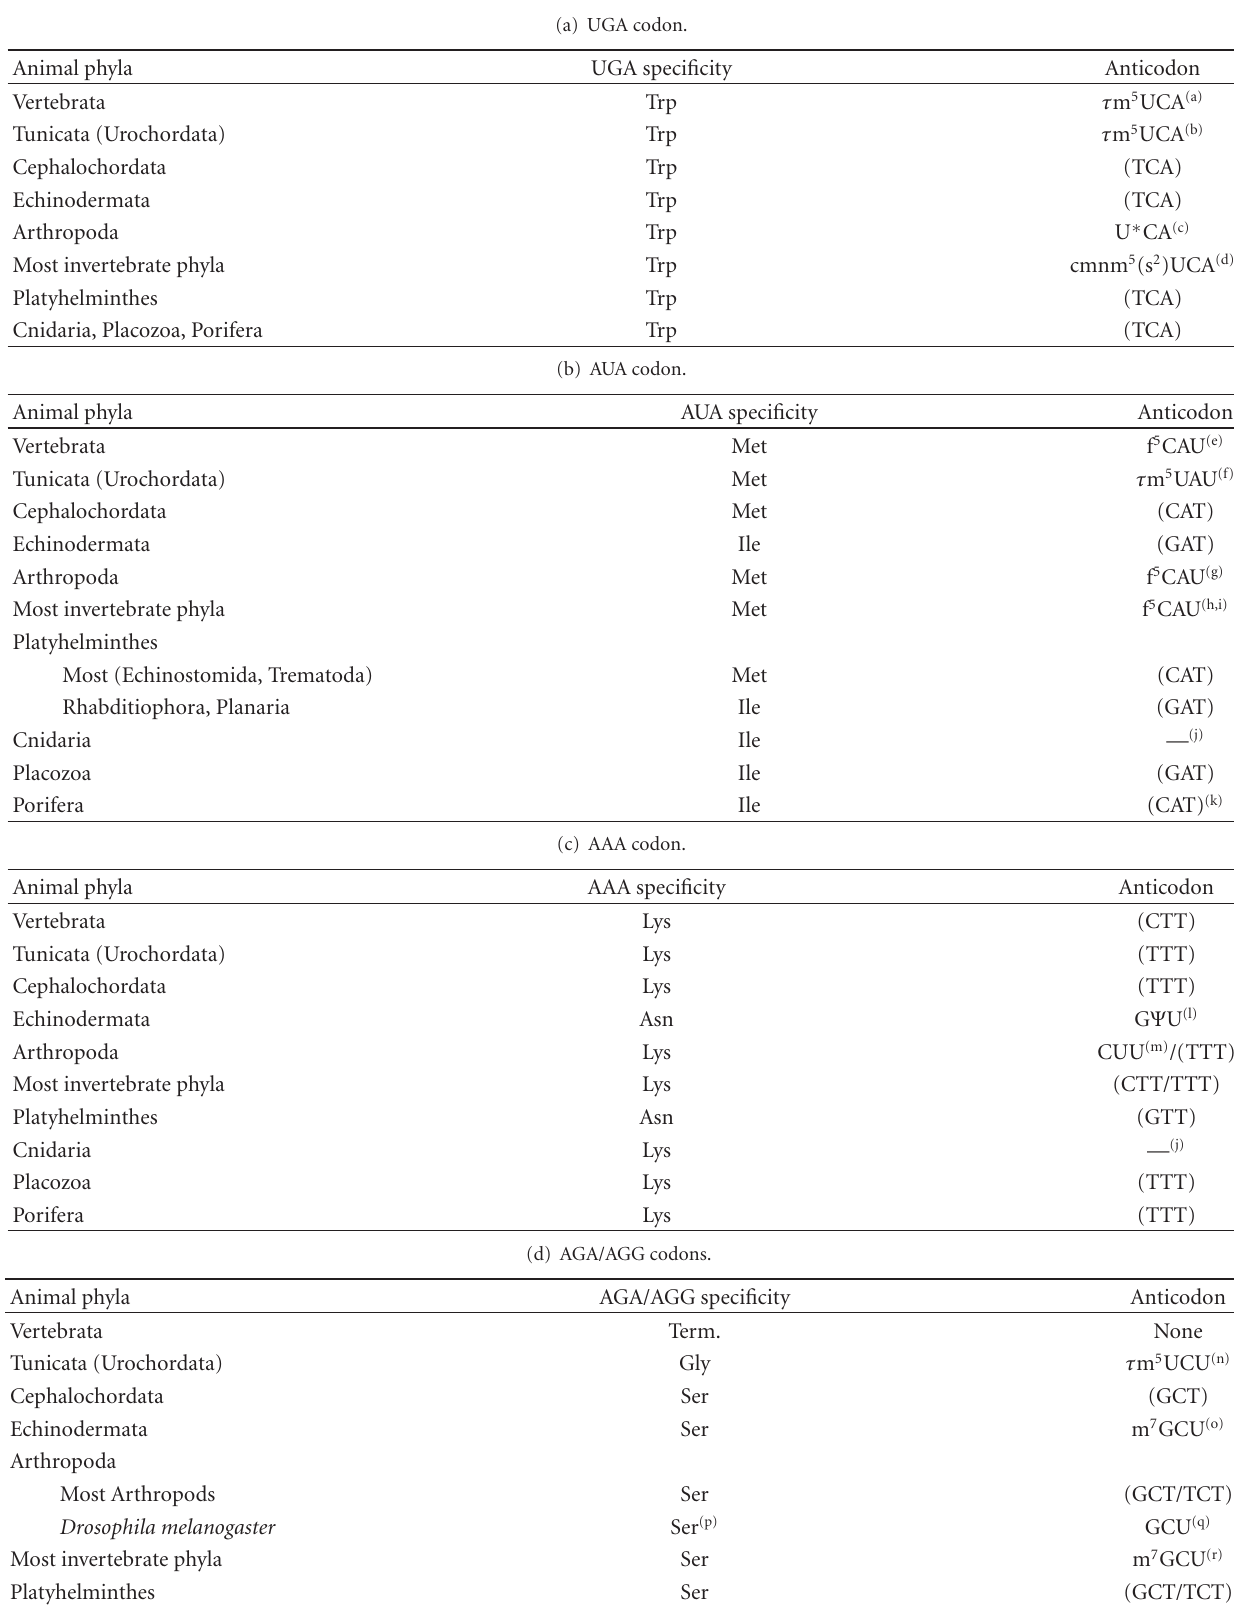
Table 1: Relationship between the genetic code variations and modified nucleosides in the anticodon of the corresponding tRNAs in the animal